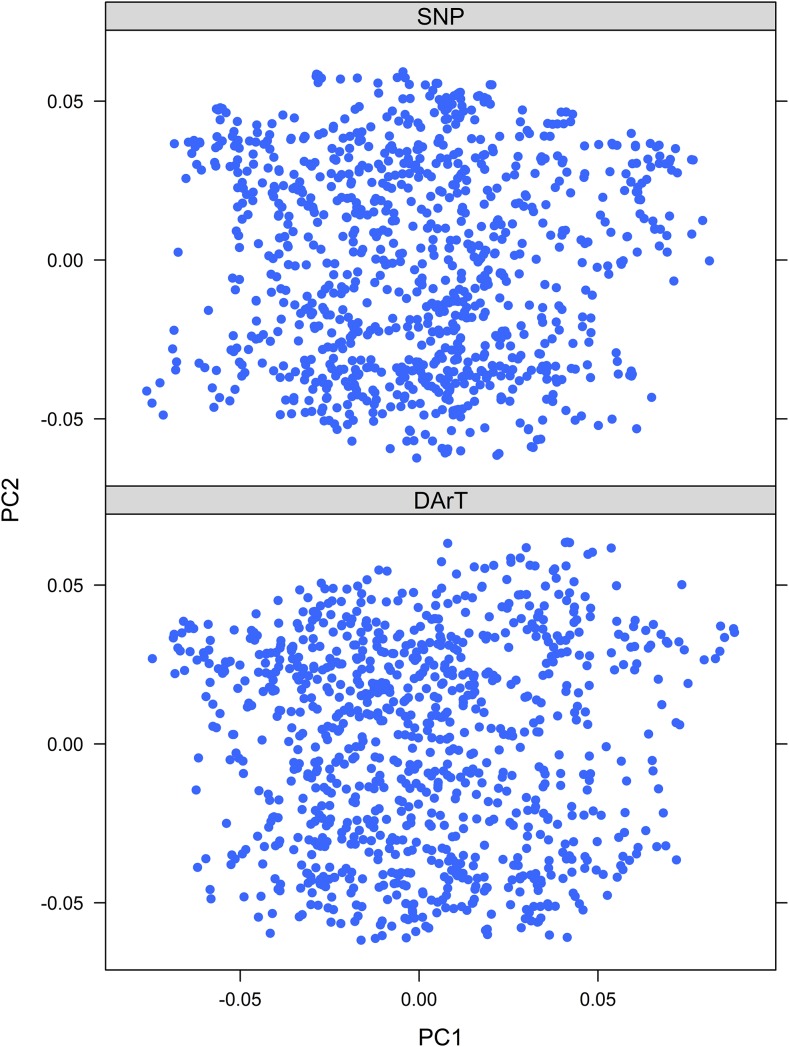
PCA plot of the first two eigenvectors from the relationship matrix of each marker set. For both marker types, the first two principle components account for ∼15% of the observed variation in genomic relationships.